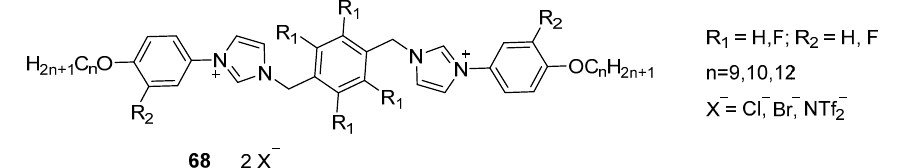
Figure 15. Influence of fluorine substituents on the phase behavior of terphenyl mesogens. Whereas the core terphenyl shows a smectic phase, the layer formation can be suppressed using fluoro- substituents. The most effective position is either in the central ring 66 , or on the ortho positions of the outer rings 67 .